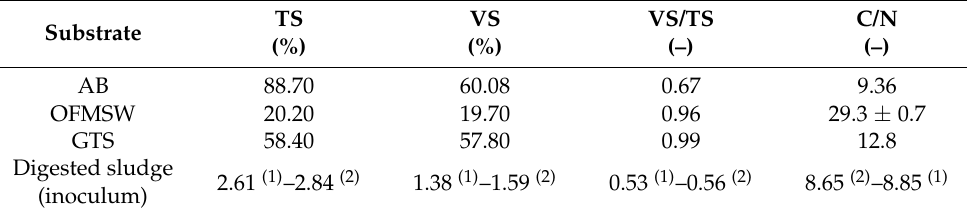
Table 1. Characteristics appertaining to the organic composition of the selected